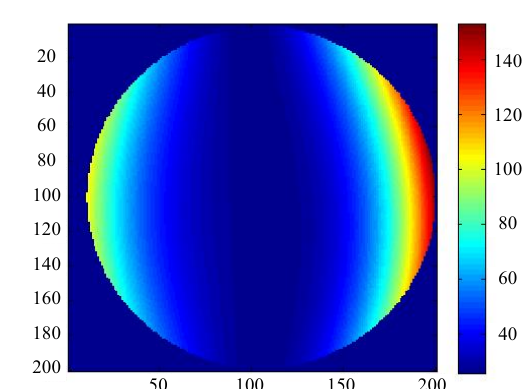
Fig. 3 Calibration results of the zeroth order effect